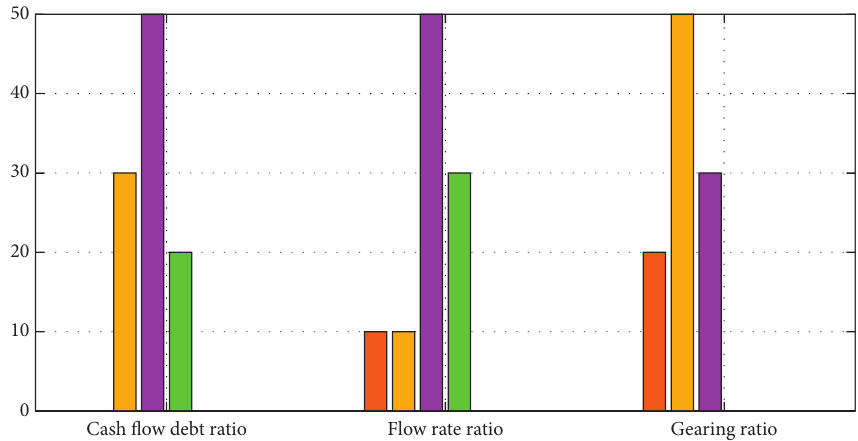
Figure 4: Histogram of funding risk indicator score results.